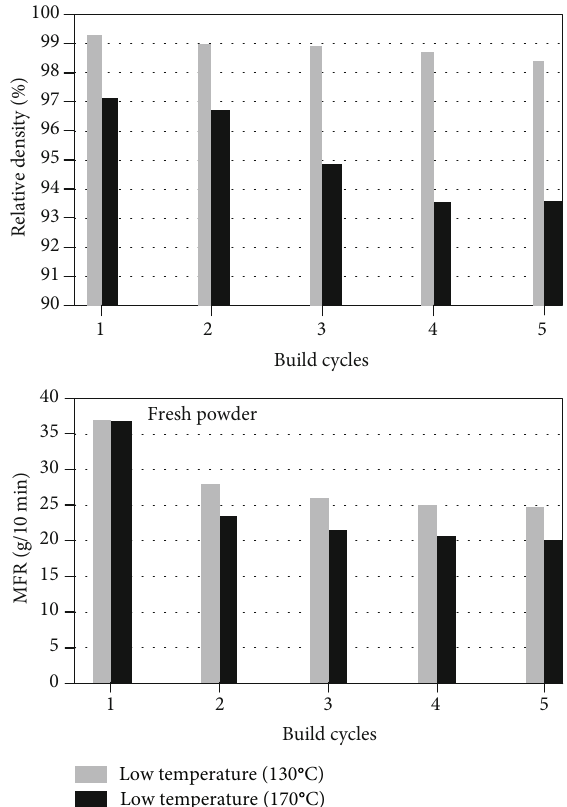
Figure 10: E ff ect of low- and high-temperature laser sintering on the relative density and melt fl ow rate of PA-12 [53].